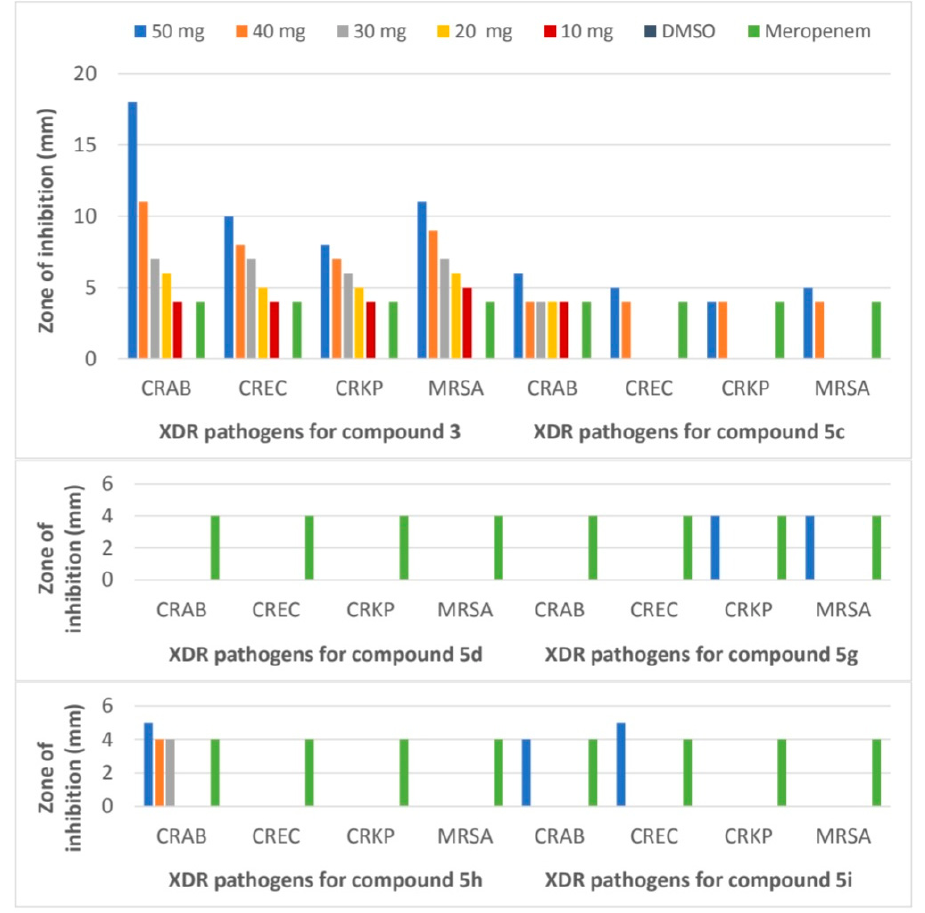
Figure 2. Agar well diffusion of different compounds against XDR pathogens. Table 2. MIC (mg/)mL and MBC of compound ( 3 ) against XDR pathogens. Table 1. Agar well diffusion of different compounds against XDR